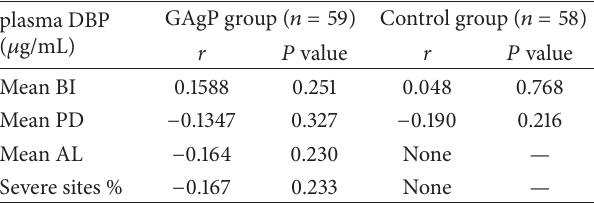
Table 4: Partial correlations between plasma DBP concentrations and clinical parameters after adjusting for age, gender, smoking status, and BMI